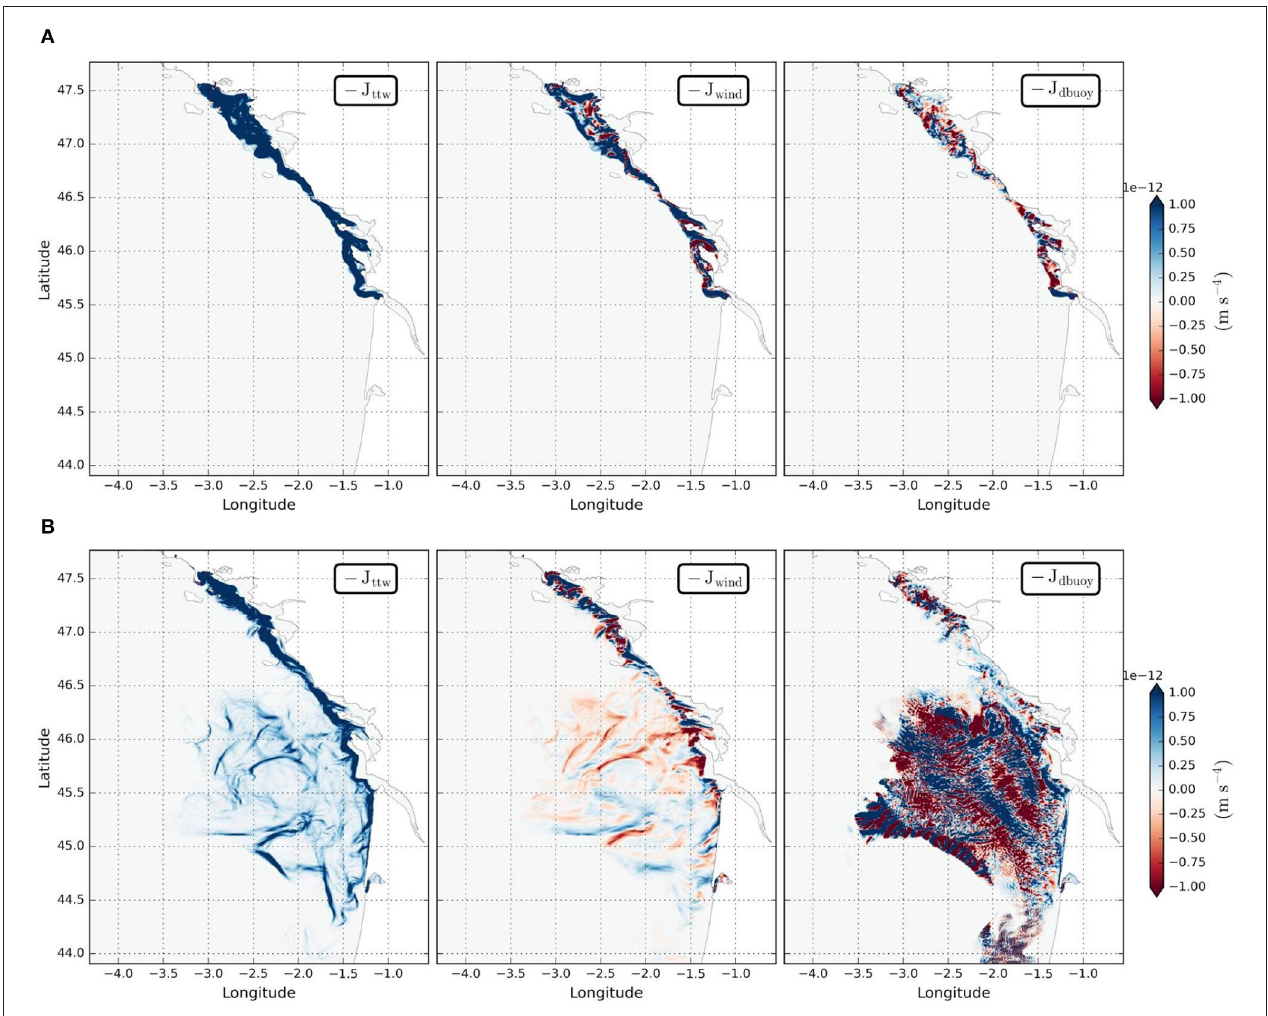
FIGURE 14 | The PV fluxes: thermal turbulent wind (-Jttw), the wind-driven (-Jwind), and the surface buoyancy (-Jdbuoy) in March (A) and in August (B)